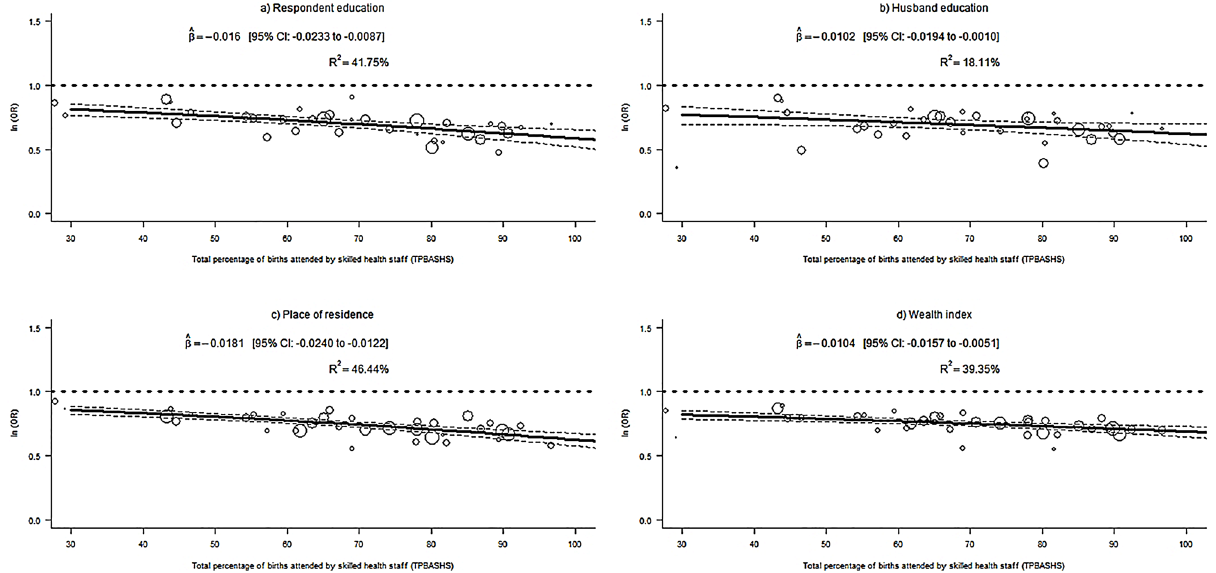
Figure 6. Meta-regressions of C-section delivery and socio-economic factors, ( a ) respondent education: TPBASHS ( b ) husband education: TPBASHS ( c ) place of residence: TPBASHS ( d ) wealth index: